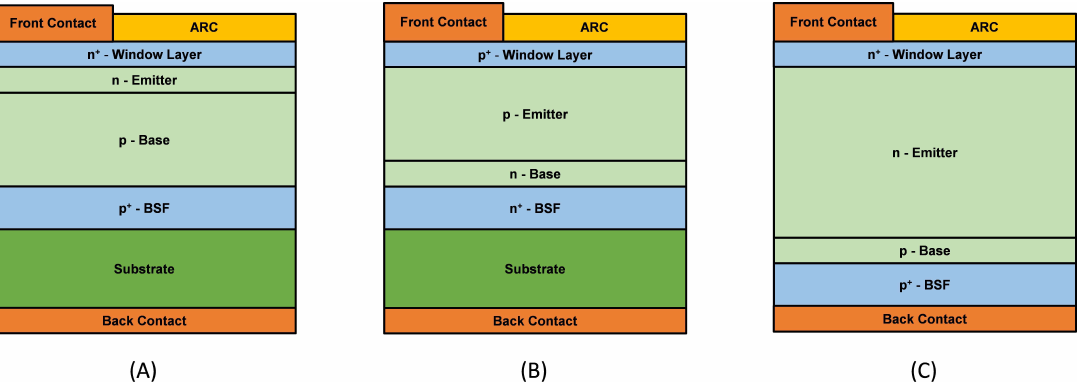
Fig. 10. Cross-sectional view of conventional cell structures of a PV diode. (A) Traditional n-type emitter on p-type base structure with p-type substrate. (B) Traditional p on n configuration with n-type substrate. (C) Thin-film III–V back-junction structure with high reflectance back contact to enhance photon